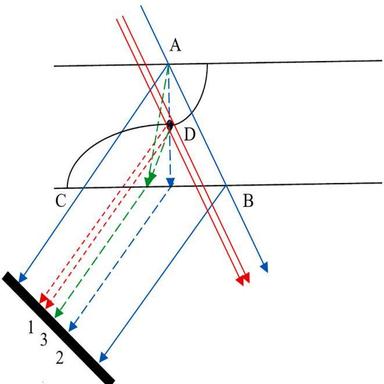
Drawing that schematically shows the origin of the various images of a dislocation: the direct image, which corresponds to additional diffraction by the distorted regions D around the dislocation, shows up on (1); the dynamical image corresponds to the perturbation of the wavefields propagating through the region D, with the creation of new wavefields: it displays a lack of intensity in (2); the intermediate image, in (3) corresponds to interferences between the old and newly created wavefields (see text).